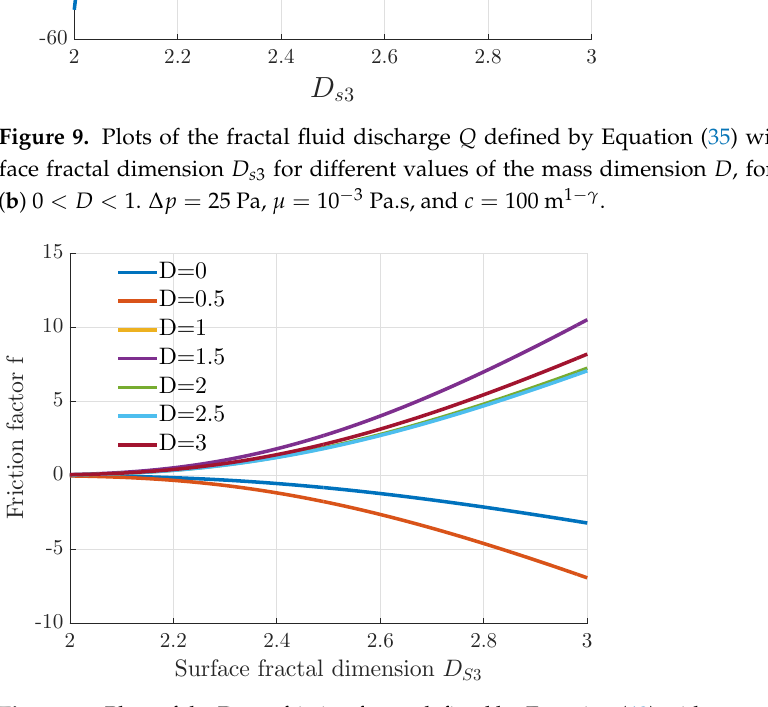
Figure 10. Plots of the Darcy friction factor defined by Equation (43) with respect to the surface fractal dimension D s 3 for different values of the mass dimension D , with ∆ p = 25 Pa, µ = 10 − 3 Pa.s, and c = 100 m 1 − γ